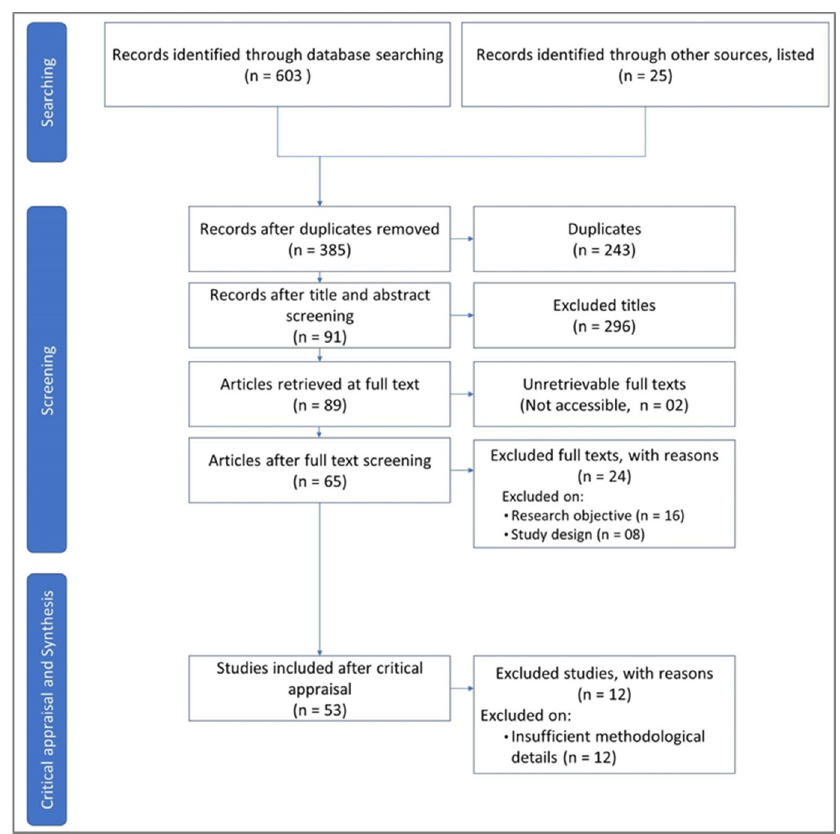
Figure 2. Methodological flow based on the ROSES (Reporting Standards for Systematic Evidence Synthesis in Environmental Research) protocol.